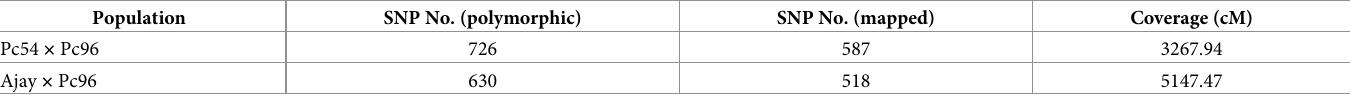
Table 2. Number of polymorphic SNPs between parental lines and mapped SNPs in the two oat mapping populations. Population SNP No. (polymorphic) SNP No.